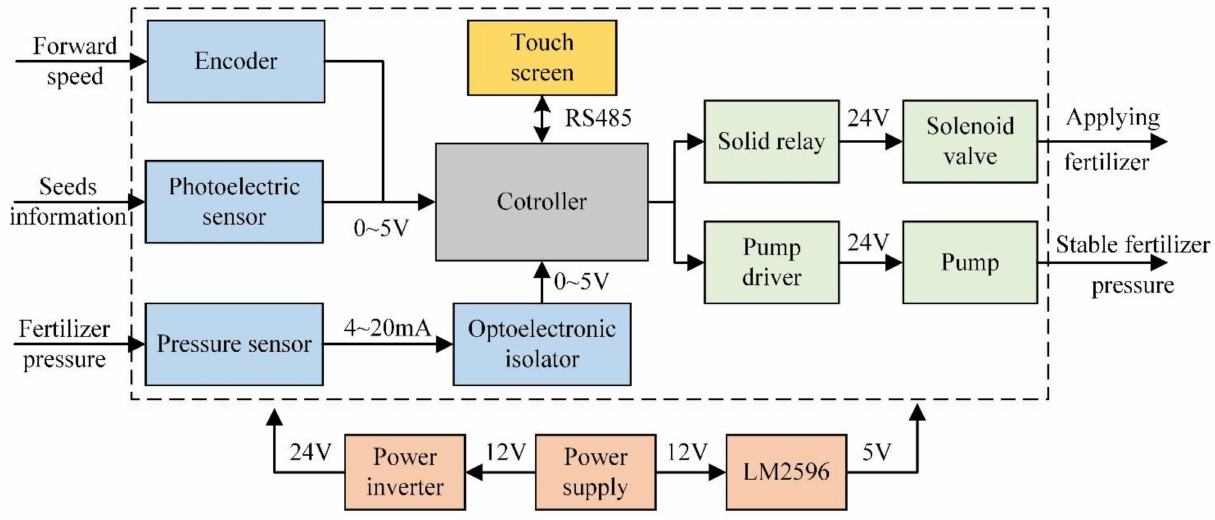
Figure 4. The hardware circuit of the detection control